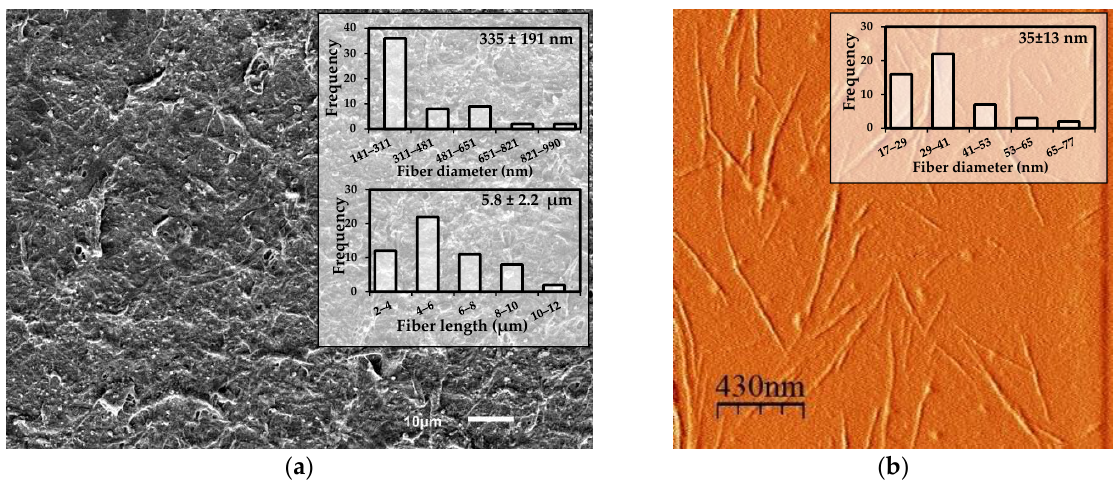
Figure 5. ( a ) SEM micrograph of TMP-NF; ( b ) AFM image of TMP-NF.